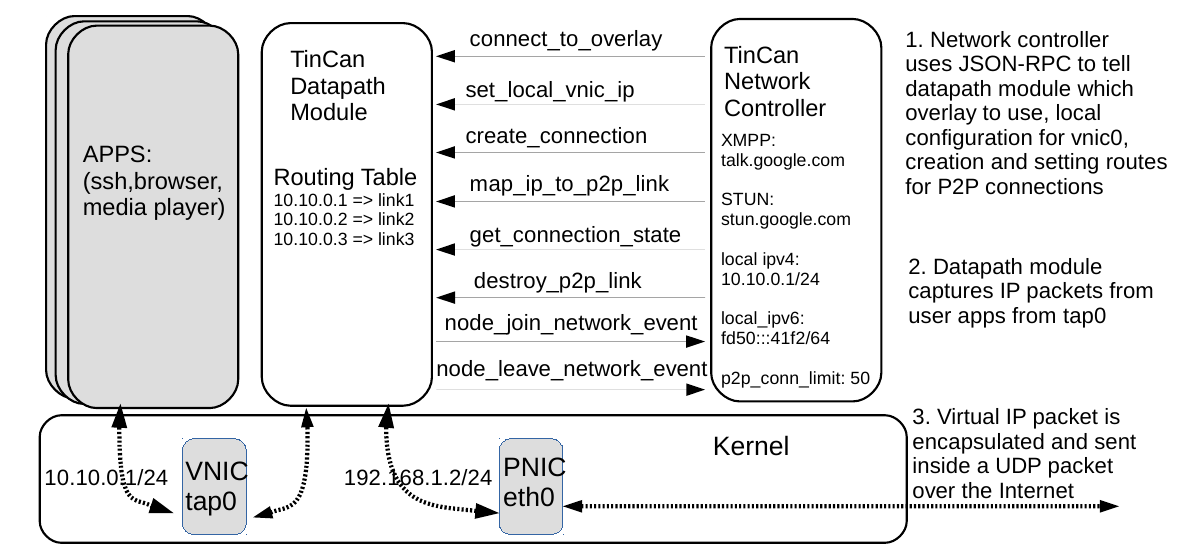
Figure 3. Interaction between TinCan